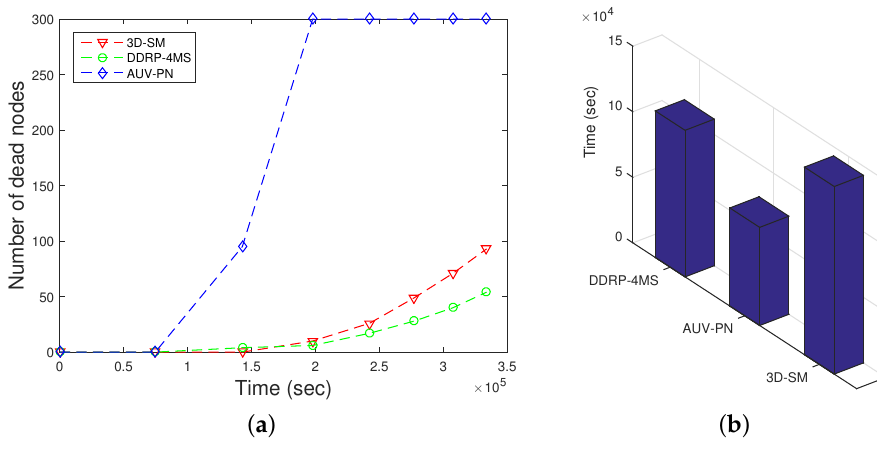
Figure 8. Network lifetime. ( a ) when all nodes die; ( b ) when first node